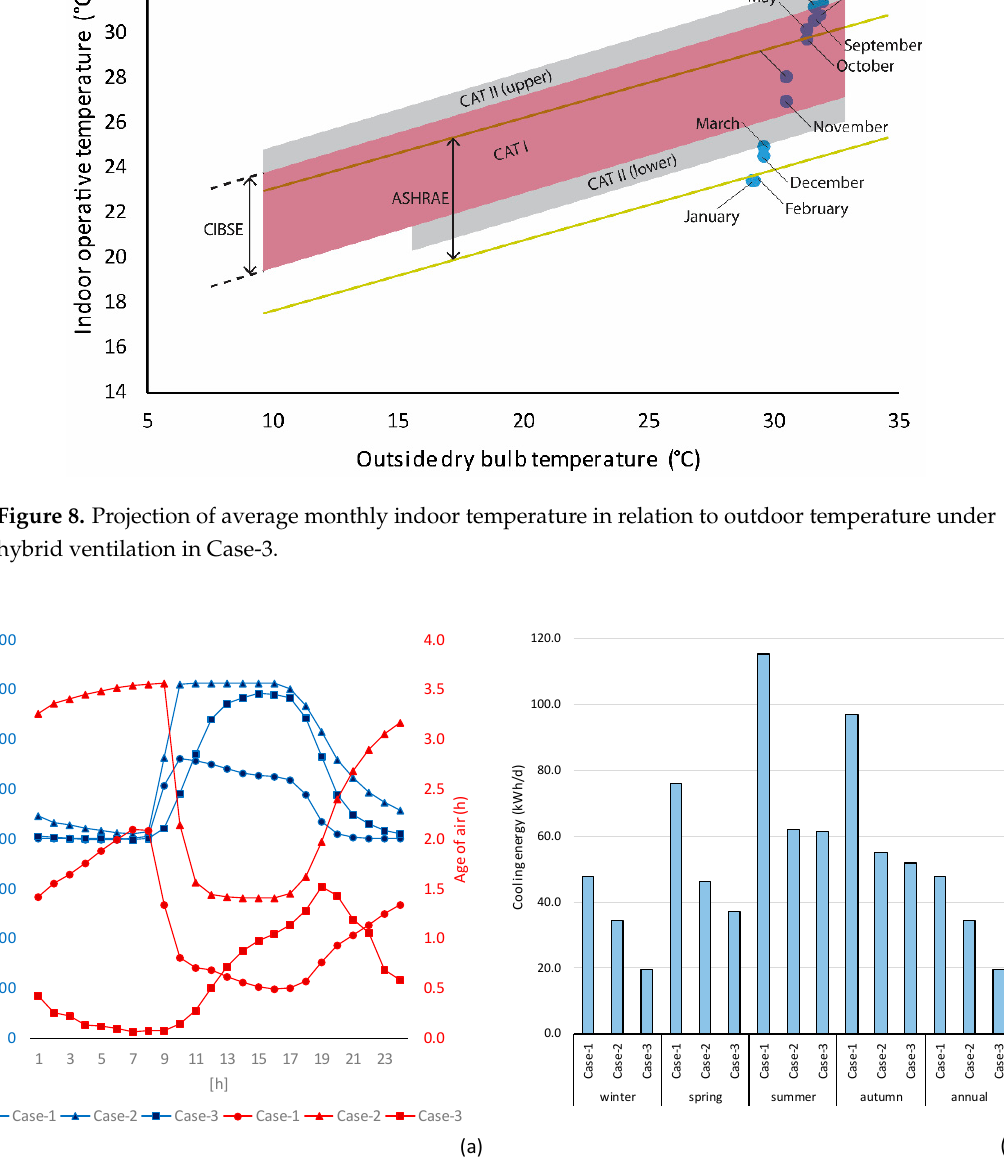
Figure 9. ( a ) Comparison of air quality on an average day; ( b ) comparison of cooling energy demand on an average day.